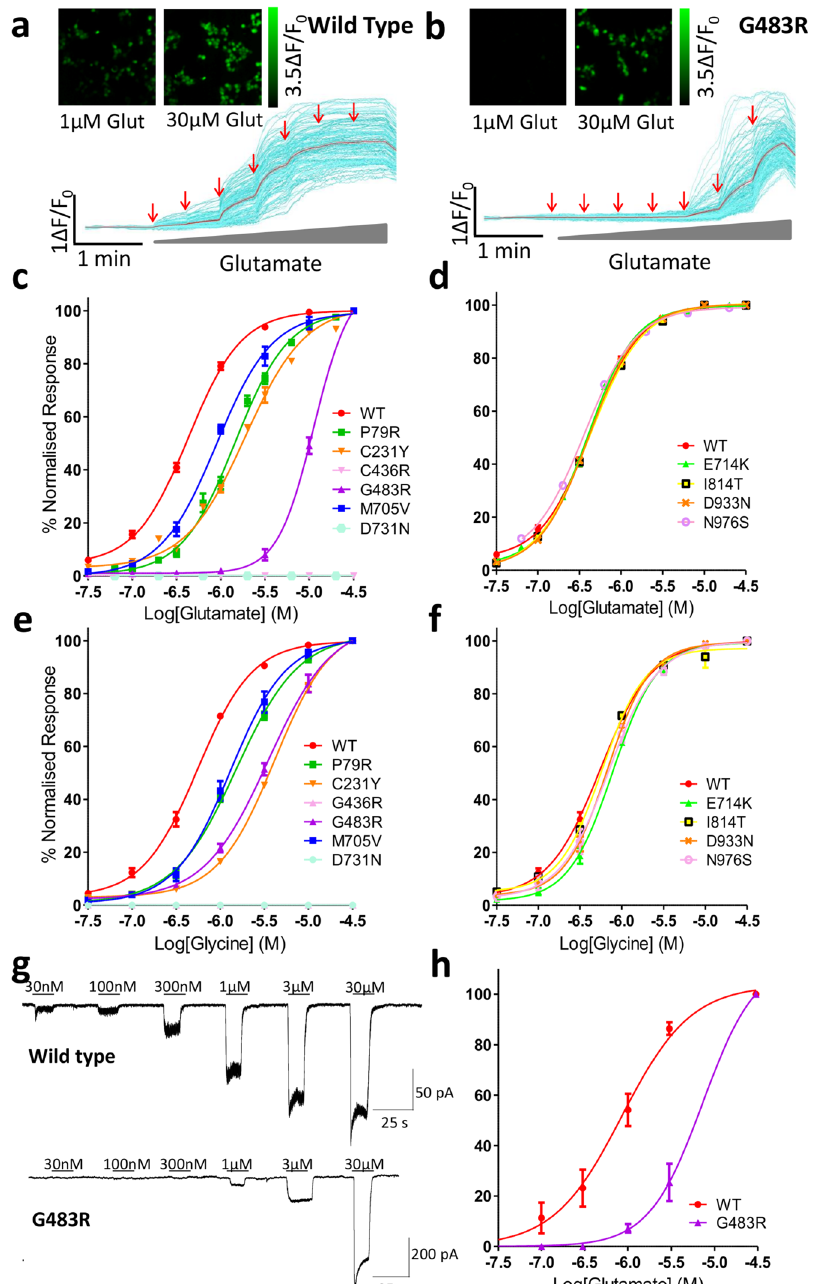
Figure 3. GRIN2A mutations alter the response to glutamate and glycine. ( a,b ) Pseudocolour images and representative single-cell traces from calcium-flux imaging for HEK cells transfected with either WT or G483R GRIN2A showing different calcium responses caused by the application of increasing concentrations of glutamate (30 nM–30 µ M red arrows). Individual cell traces in cyan and the mean response in red. ( c , d ) Normalised concentration response curves (CRCs) to increasing concentrations of glutamate from single cell calcium-flux imaging. In ( c ) 4 mutants; P79R, C231Y, C483R and M705V have reduced agonist potency, while C436R and D731N show no response to glutamate. Four mutant constructs ( d ), show an unaltered response to glutamate. ( e,f ) Normalised CRCs to increasing glycine concentration with constant 3 µ M glutamate – the mutations show similar responses as to glutamate. See Table 2 for n to create averaged data per construct, 3 × 10 4 cells/well. Error bars ± SEM. ( g ) Representative continuous voltage-clamp recordings obtained from HEK cells transfected with WT or G483R GRIN2A plasmid. Bars above the recording indicate glutamate application (co- applied with 30 µ M glycine). Application of increasing concentrations of glutamate shows a progressive increase in current observed, the sensitivity of which is shifted to higher concentrations of glutamate in the G483R mutant compared to WT. ( h ) Normalised CRC to glutamate as recorded in ( g ) indicates the same response as for single cell calcium imaging (n =